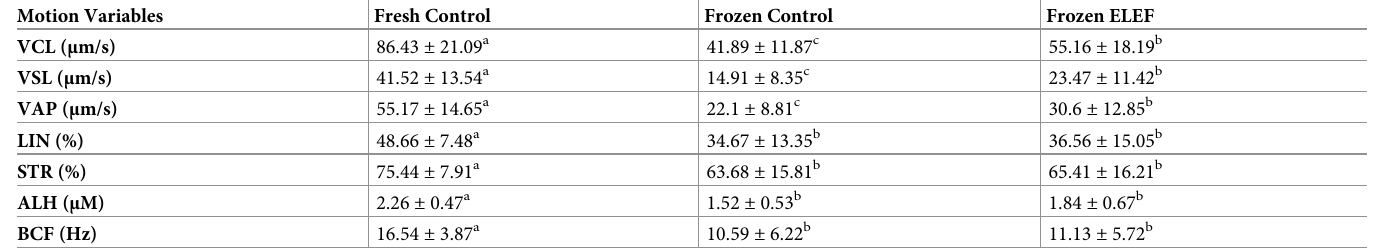
Table 2. Effects of freezing medium on sperm motion variables in frozen control and frozen ELEF. The assigned letters of a, b and c indicate significant differences (p < 0.05) among the groups. Values are expressed as mean ± SD, Tukey test; n = 25. P-value adjustment for multiple comparisons: Bonferroni.